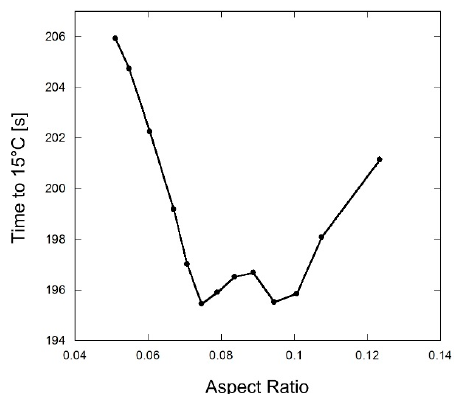
Figure 8. The time required to cool down to 15 °C for eight ‐ fin reactor with convection on the reactor cylinder wall.